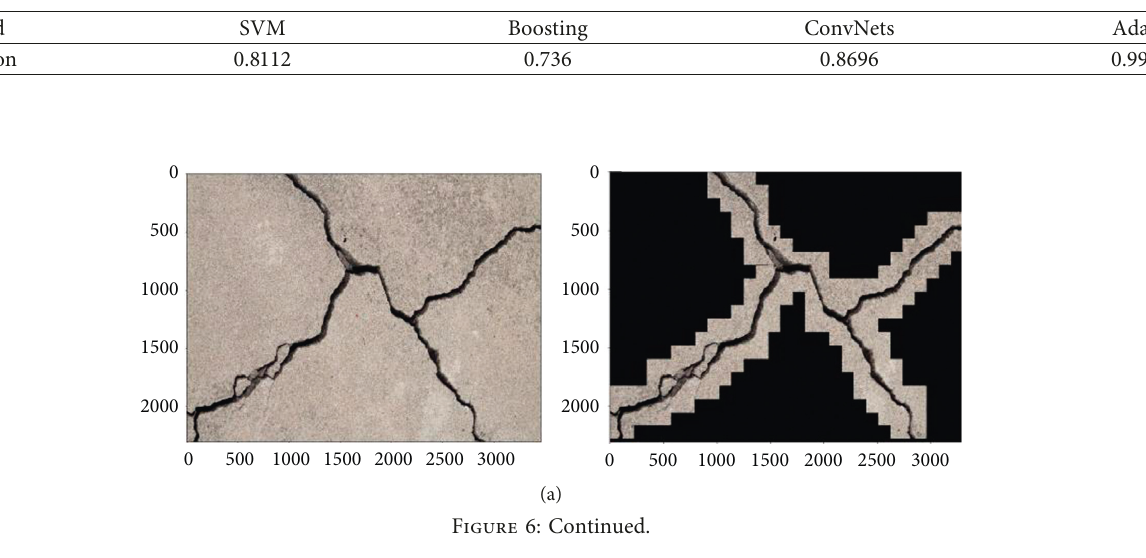
Figure 5: Correct rate change chart. The light line is the set of real data points, and the solid line is the set of points after the smoothing process. Table 2: Performance comparison of different methods.